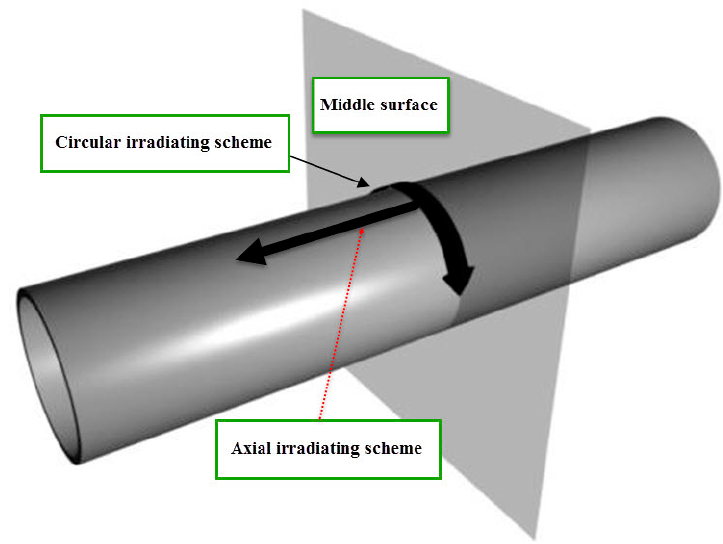
Figure 3. The schematics of the circular irradiating scheme (CIS) and axial irradiating scheme (AIS).